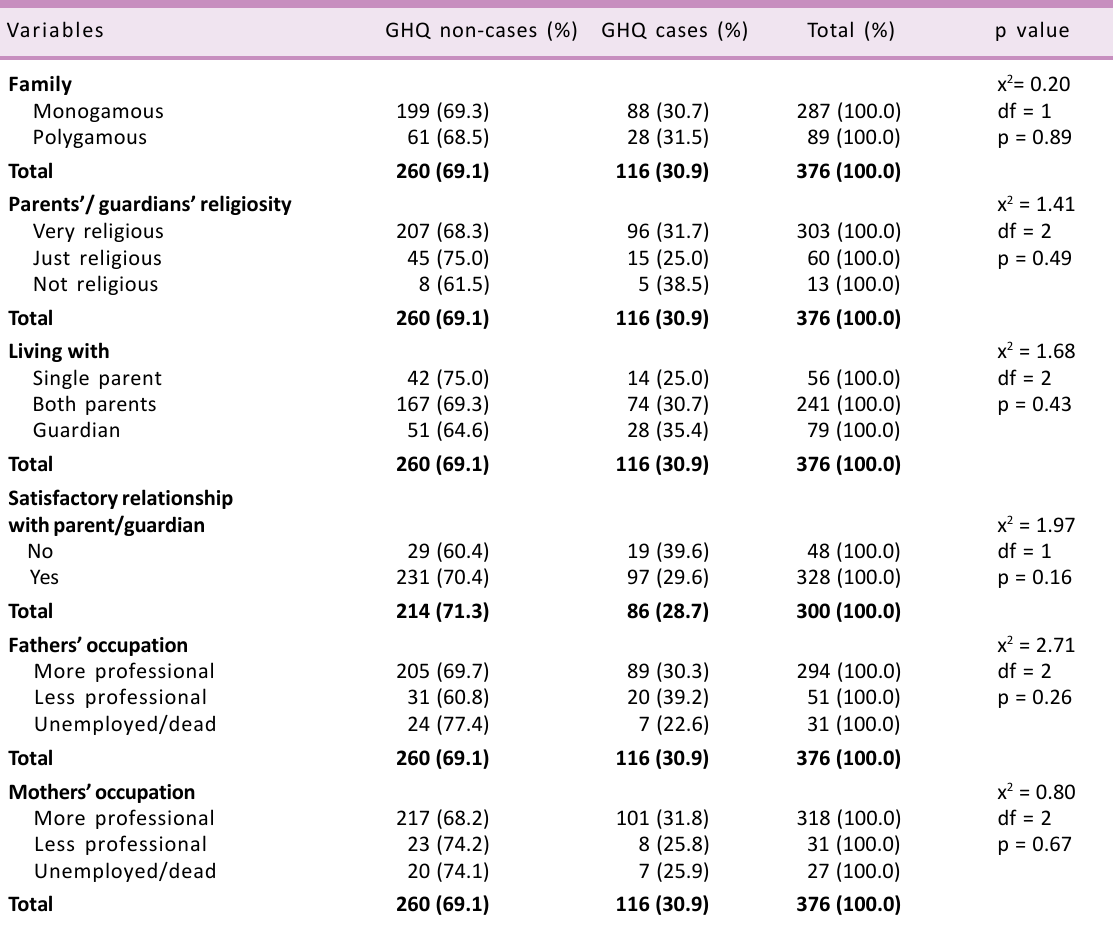
Table 2: Comparison of family-related variables of GHQ non-cases and cases